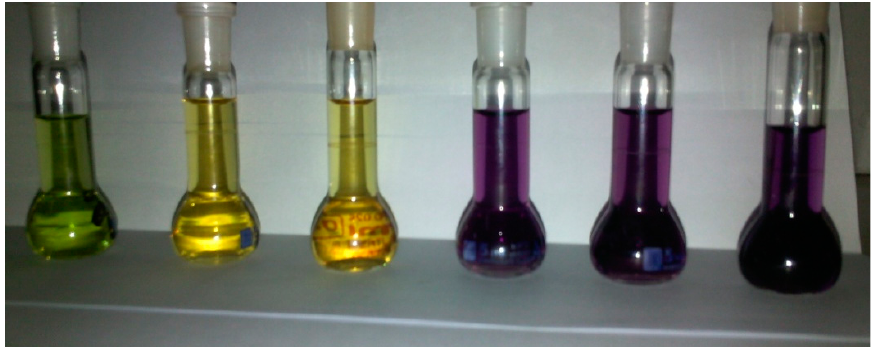
Figure 15. Absorption spectra of compound 3 and pure DPPH, the maximum absorbance was observed for the later one ( left ) and % Inhibition versus concentration of compound 3 for radical scavenging activity ( right ).